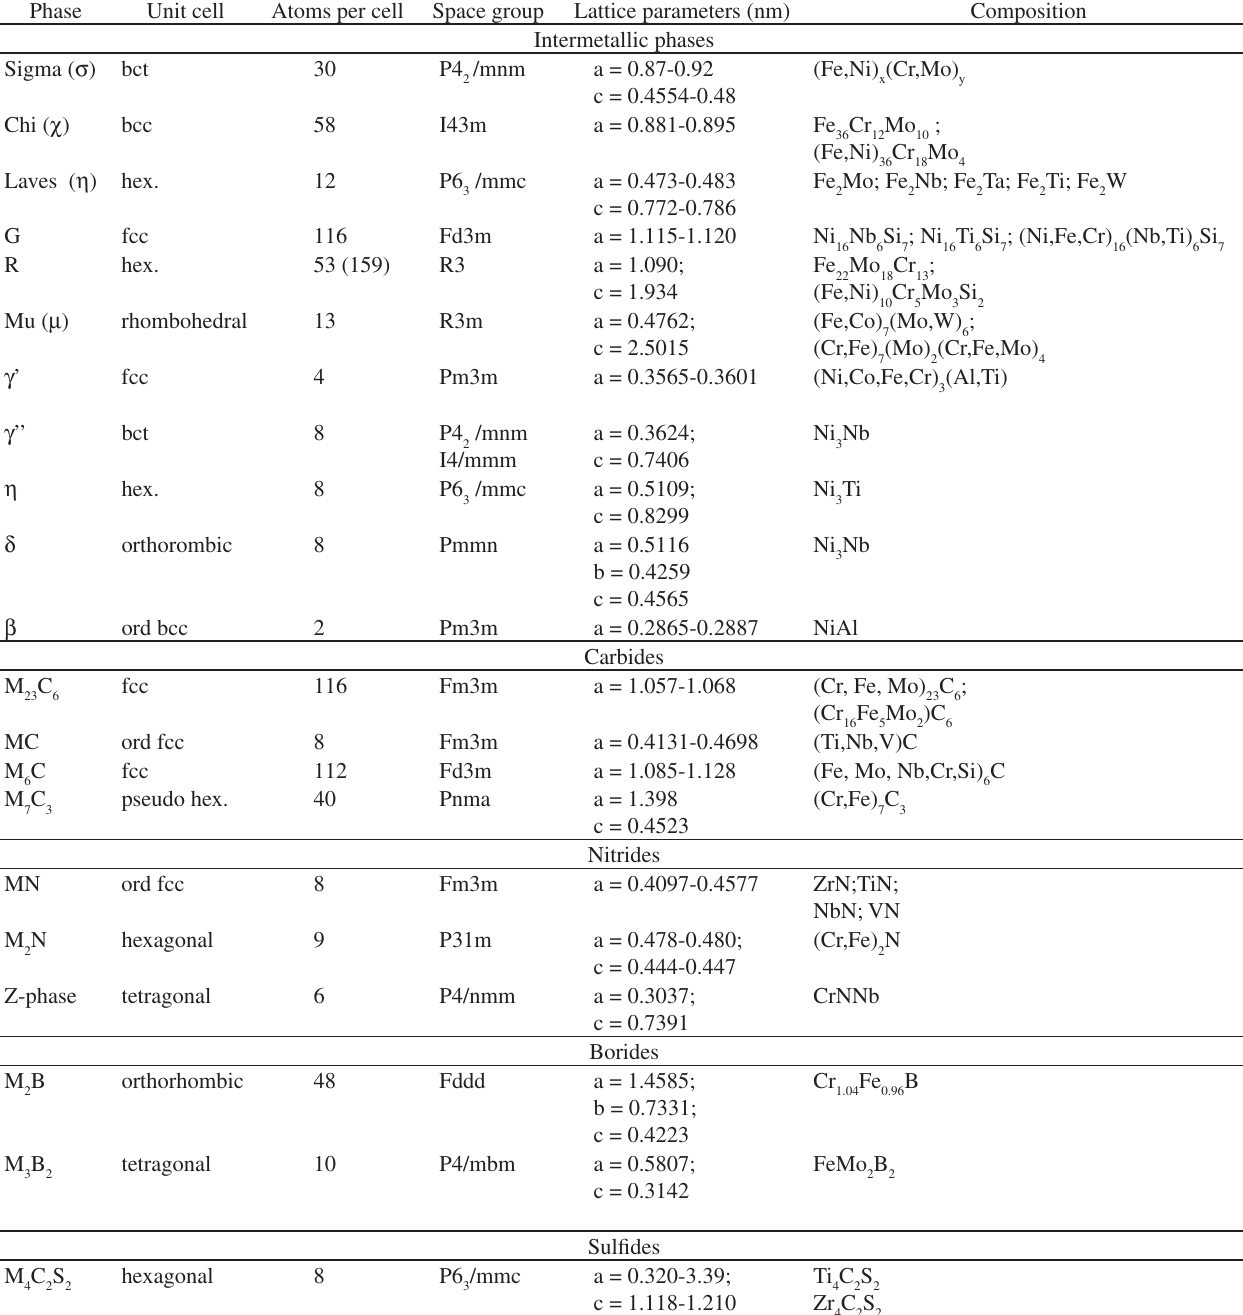
Table 2. Crystal structures and compositions of phases that may occur in stainless steels 1,2 . Phase Unit cell Atoms per cell Space group Lattice parameters (nm) Composition Intermetallic